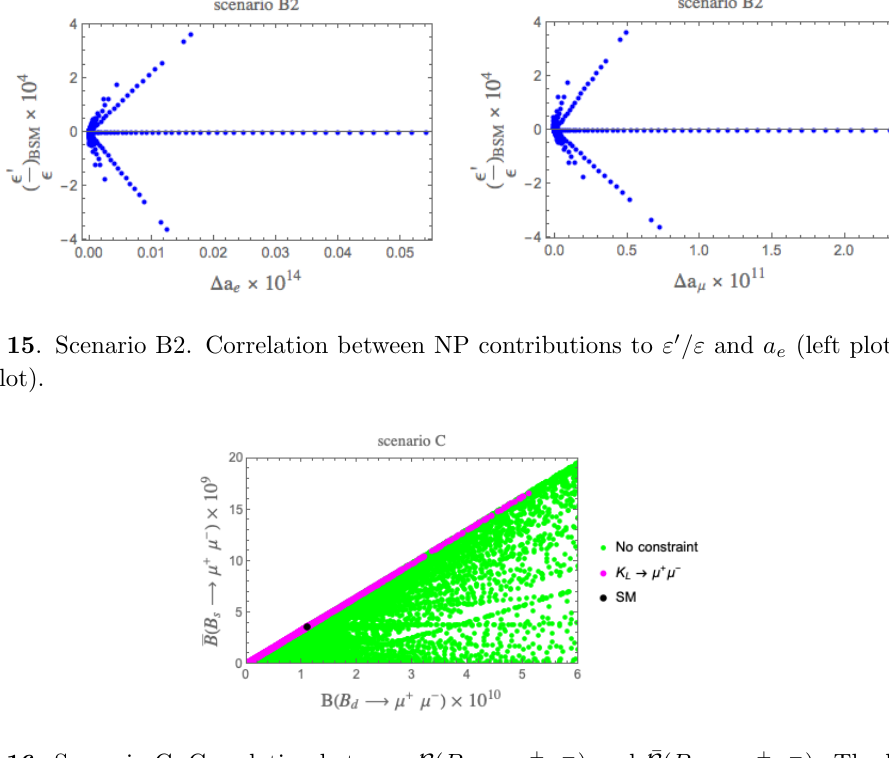
Figure 16 . Scenario C. Correlation between B ( B d ! (cid:22) + (cid:22) (cid:0) ) and (cid:22) B ( B s ! (cid:22) + (cid:22) (cid:0) ). The black dot represents the central value of the SM